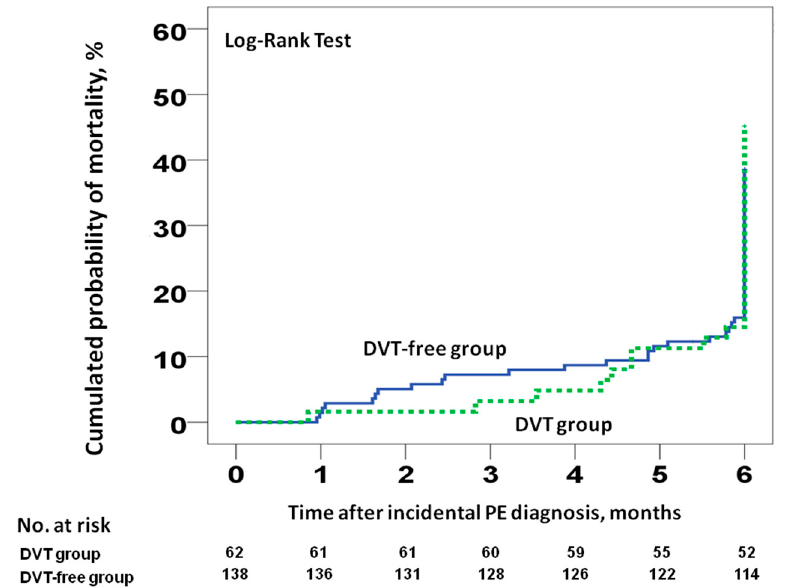
Figure 2. All-cause mortality at six months for patients with incidental PE, stratified according to the presence or absence of concomitant incidental DVT at the time of PE diagnosis. Abbreviations: DVT: deep vein thrombosis; PE: pulmonary embolism. Log-rank p > 0.05.